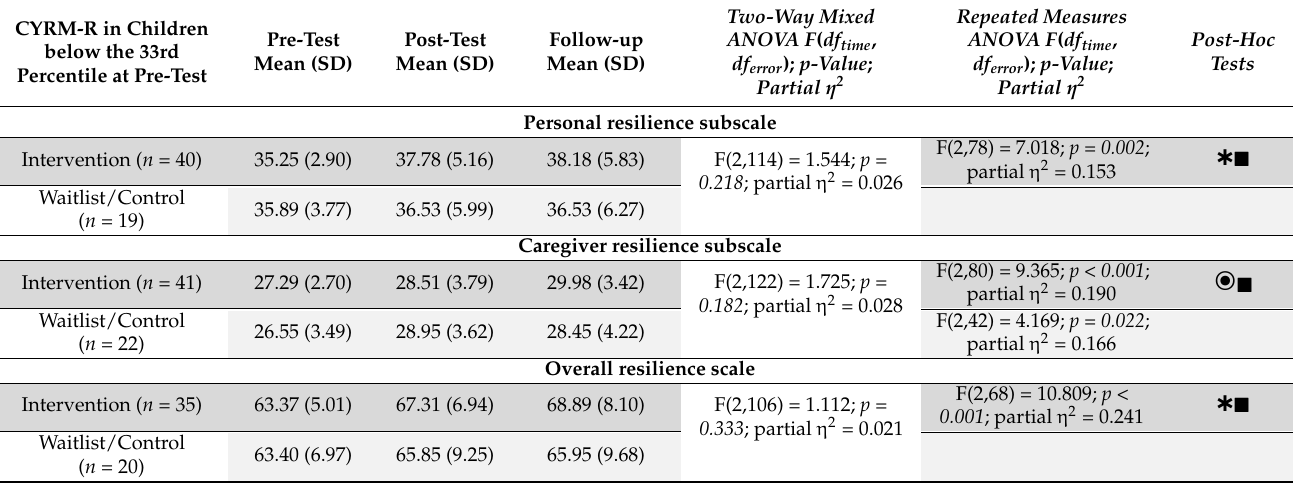
Table A4. Mean PAFAS scores over time in caregivers above the 66th percentile at pre-test. ( Higher scores indicating lower levels of Parenting and Family Adjustment skills ).